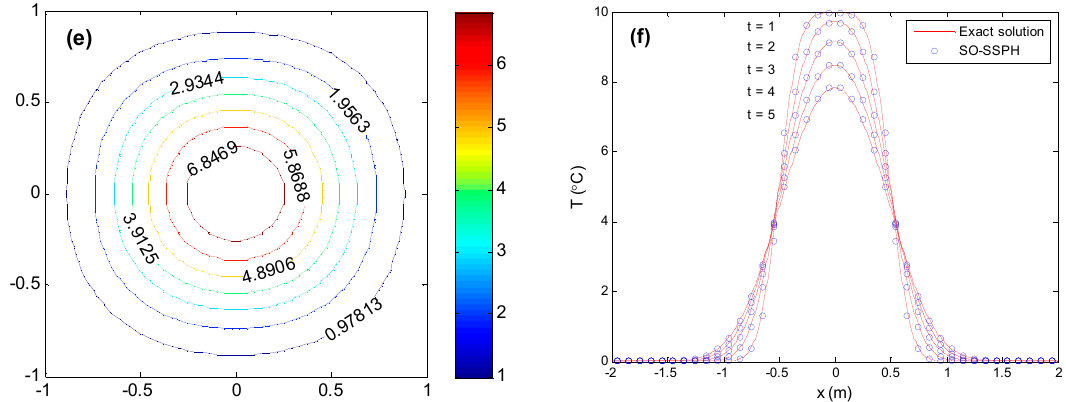
Figure 4. Temperature contours at different times: ( a ) t = 1 s; ( b ) t = 2 s; ( c ) t = 3 s; ( d ) t = 4 s; ( e ) t = 5 s; and ( f ) temperature distribution along y = 0.05 m compared with exact solutions.